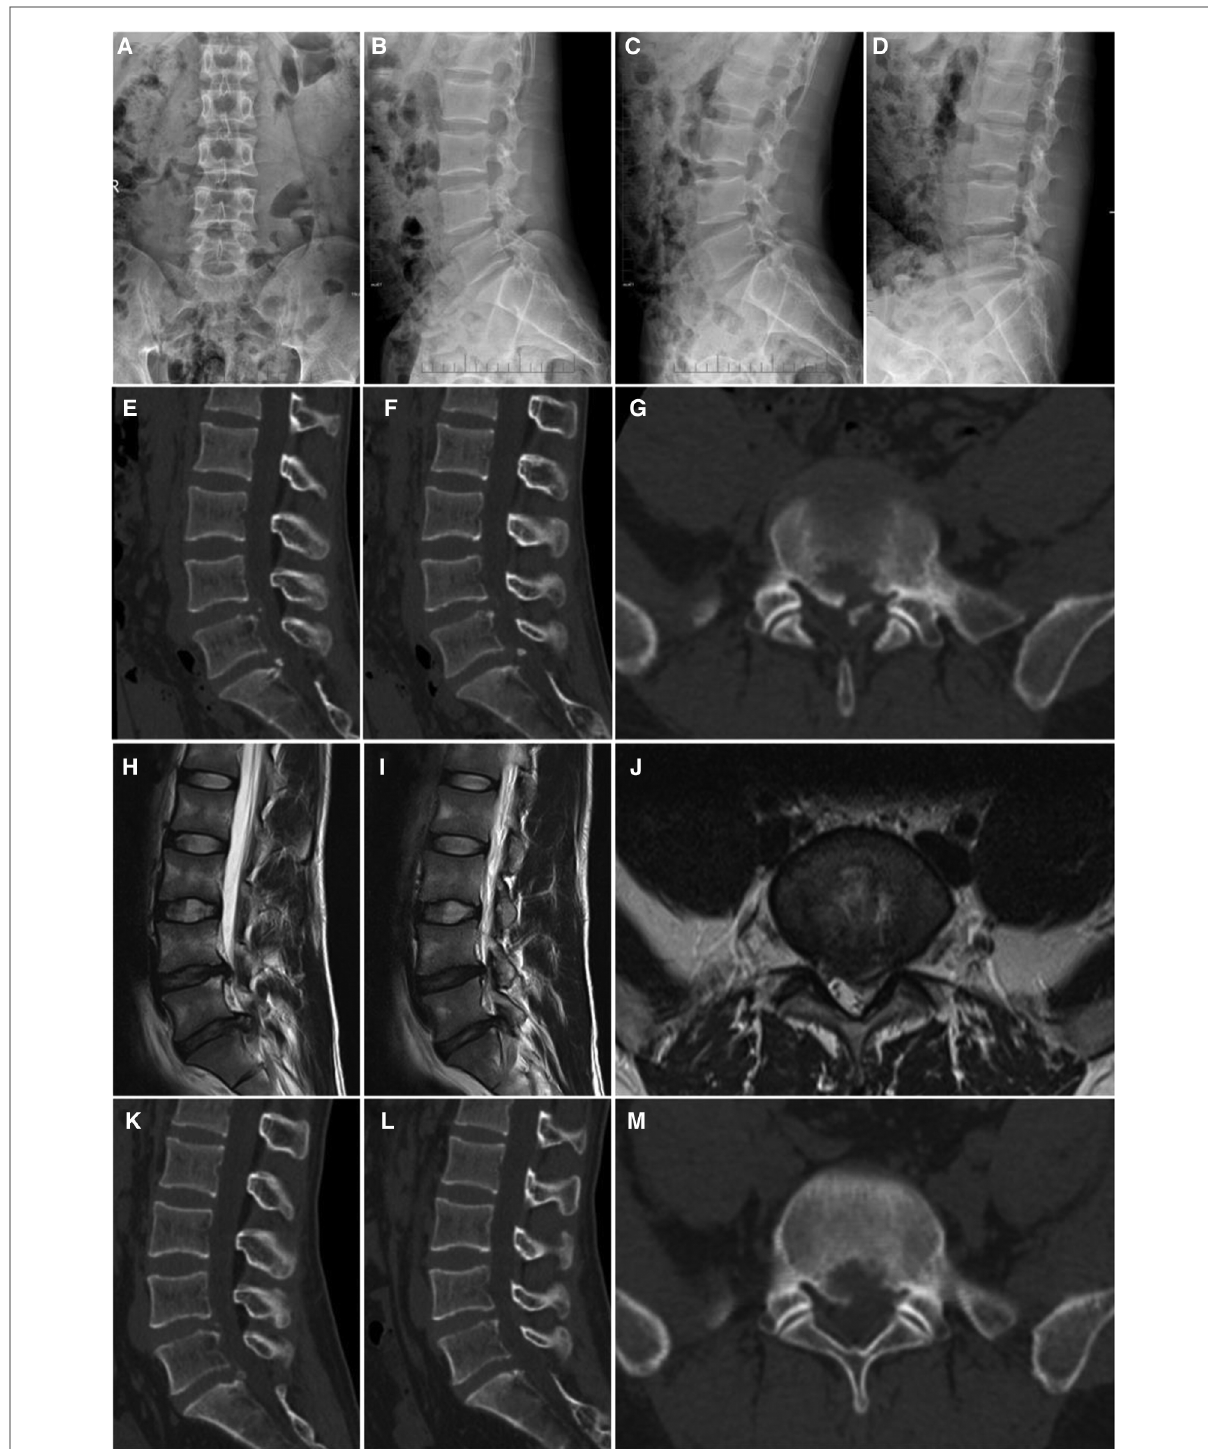
FIGURE 1 A 26-year-old man with LDH linked with PRAS was treated with PETD; the main symptoms were low back pain with radiating pain in the left lower limb. ( A,B ) anterior and lateral X-ray images of the lumbar, ( C,D ) dynamic X-ray images of the lumbar, ( E – G ) CT scan images of the lower lumbar spine: the detached bone fragment is shown to protrude into the posterior margin of the vertebral body, ( H – J ) MRI of the lumbar spine: the imaging fi ndings were consistent with that of the CT scans, and some of the discs are shown to protrude laterally, ( K – M ) the CT scan images show that the bone fragment pressing the nerve on the patient ’ s left side has been